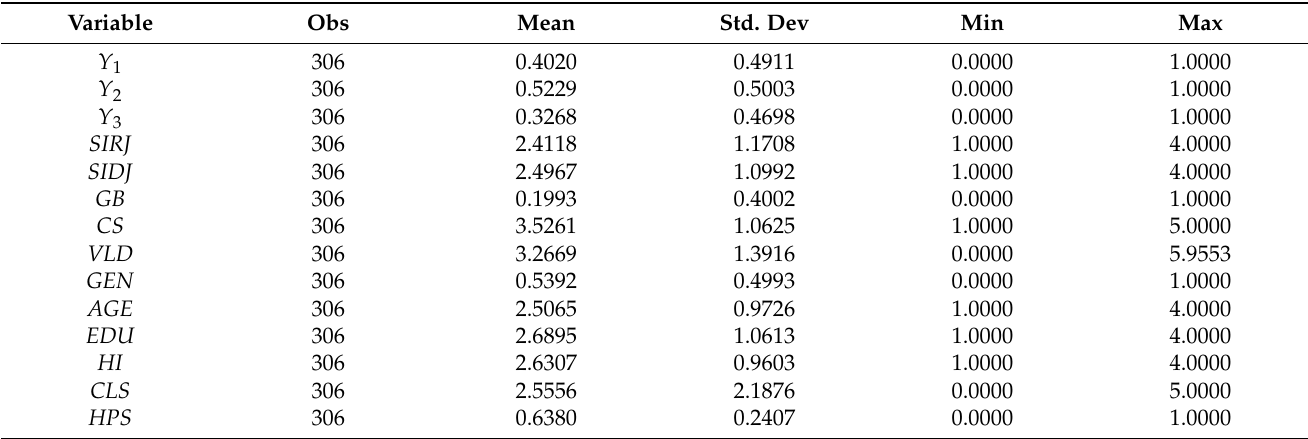
Table 2. Descriptive statistics of the